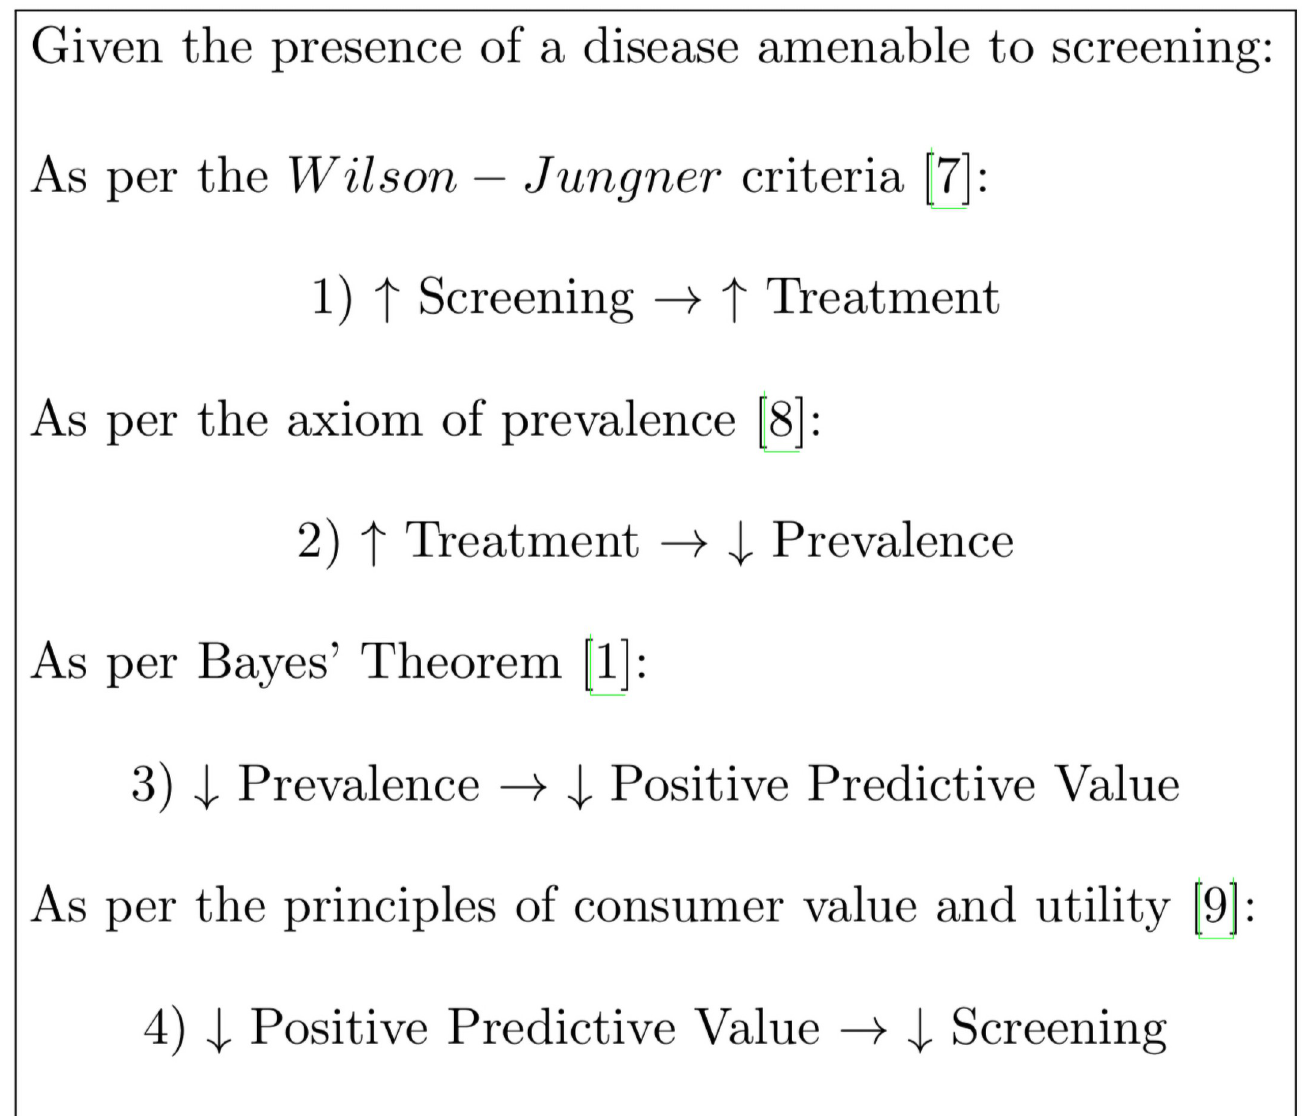
Fig 2. The process by which the screening paradox